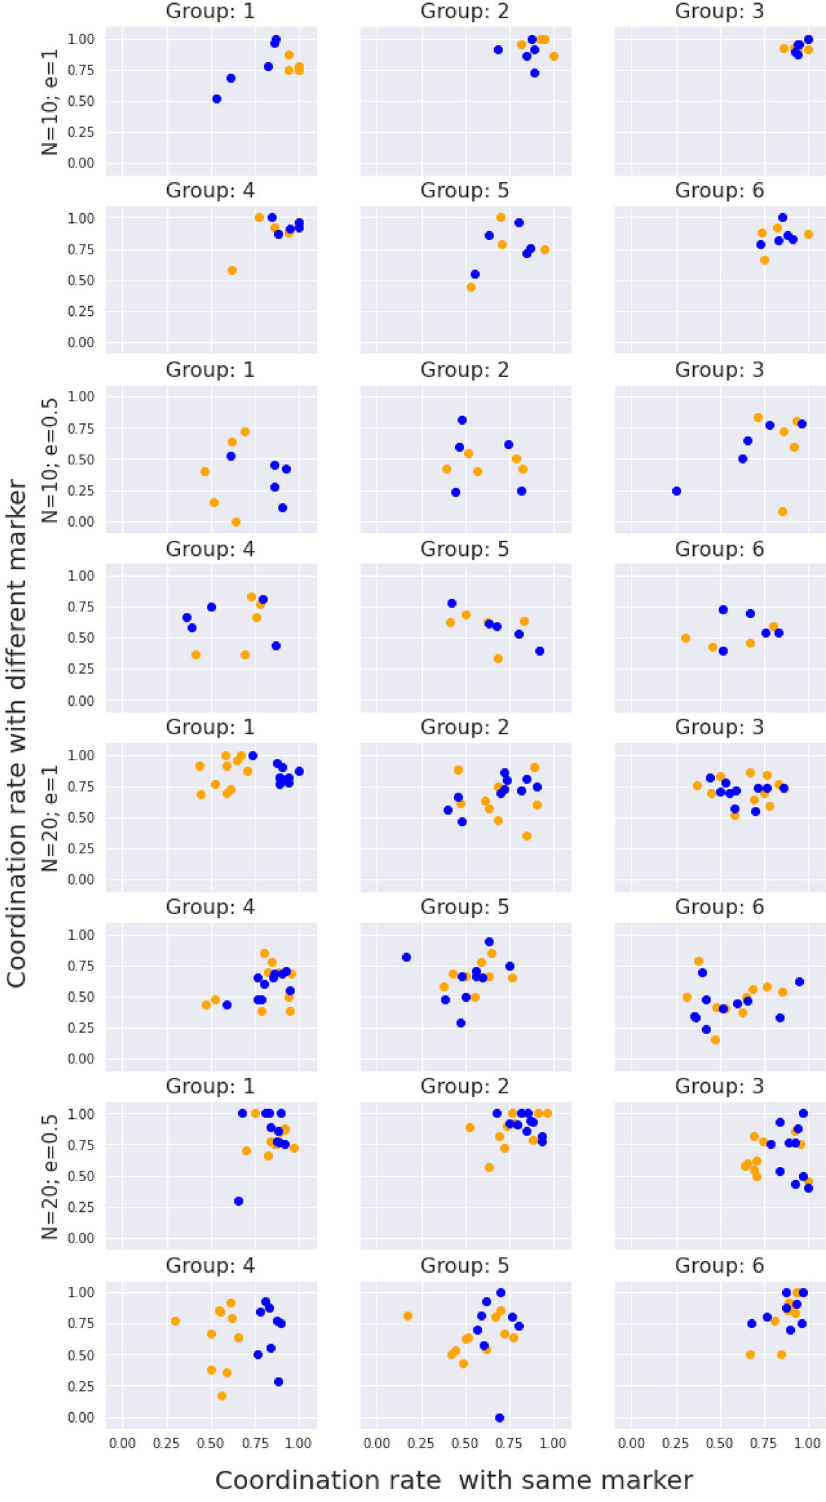
Figure 1. Experimental profiles of coordination rates for the transient(rounds 0 to 40); X-axis: coordination rate within the subpopulation that shared the same marker as the individual; Y-axis: coordination rate within the subpopulation that shares the complementary marker. Coloured, the marker of the